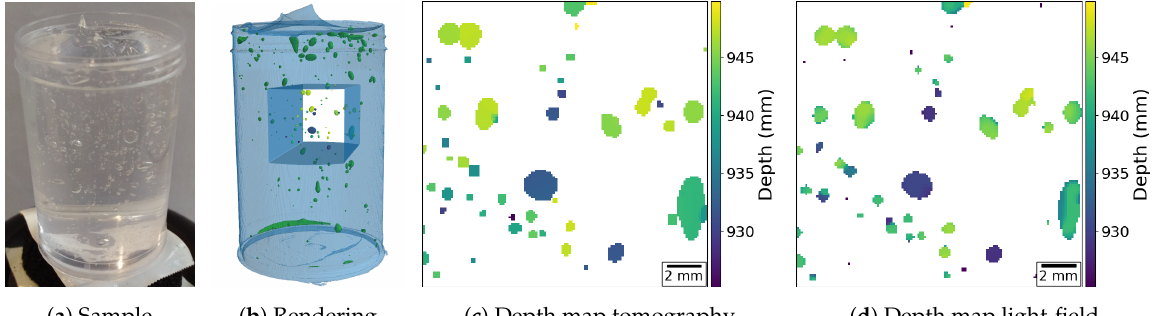
Figure 6. X-ray light-field imaging of air bubbles in gel to demonstrate the ability to capture the three-dimensional (3D) position and shape of sphere-like objects. ( a ) Sample; ( b ) Rendering of the tomographic reconstruction with emphasis on analyzed region; and, ( c , d ) present the depth maps extracted from the tomographic and the light-field reconstruction, respectively.